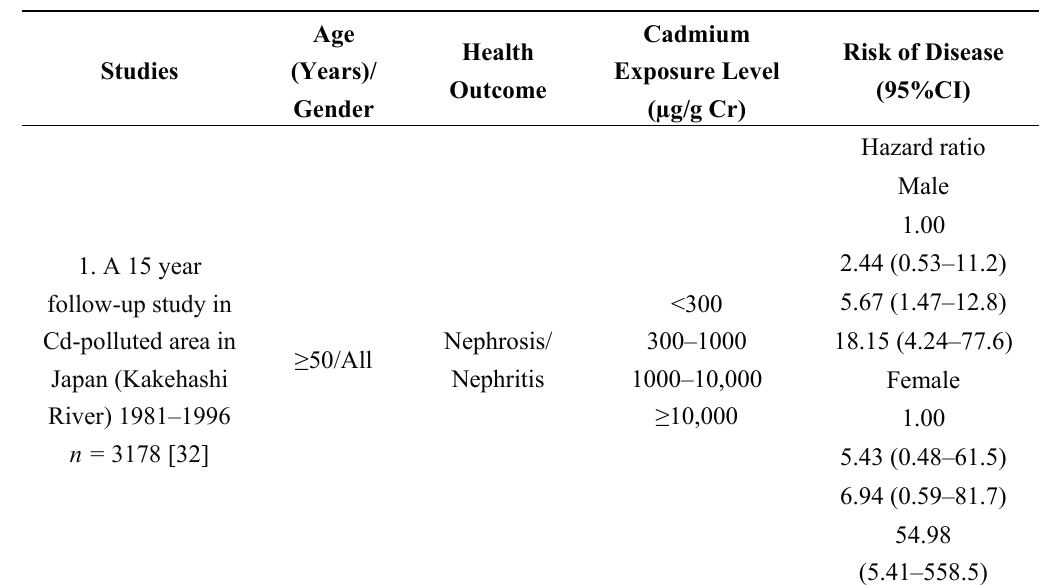
Table 2. Selected studies with β 2 -MG in urine and risk of health outcome for PAF estimation in Mae Sot